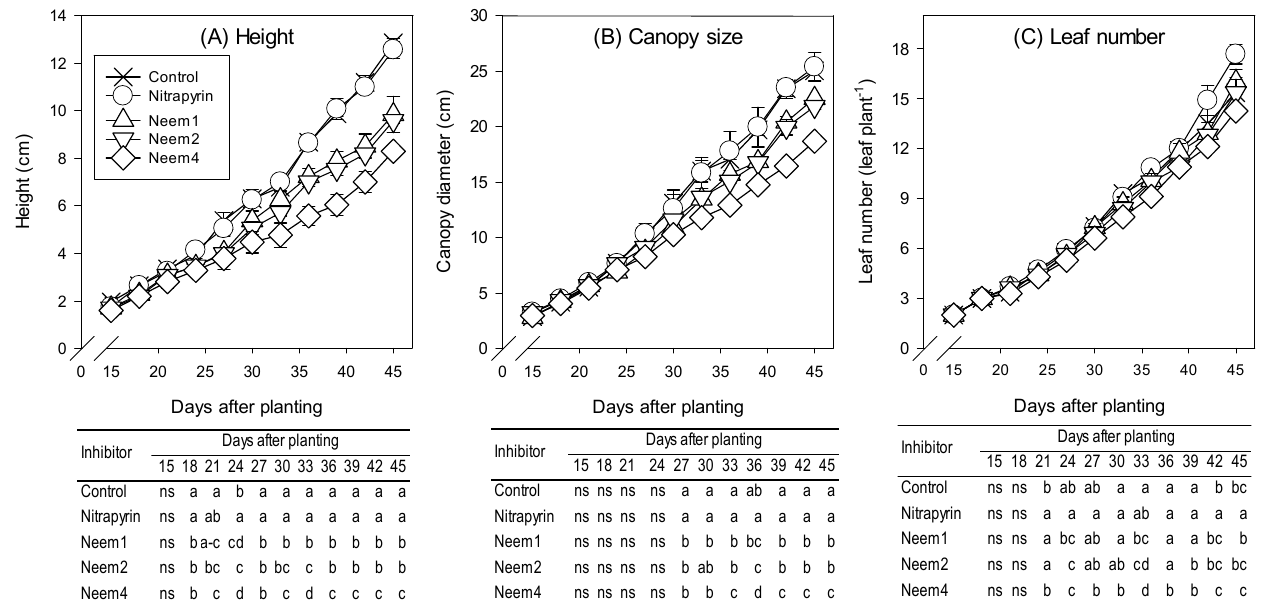
*** = p ≤ 0.001; CV = coefficient of variation. † Neem1, Neem2, and Neem4 = neem leaf extract based on the dry weight of the raw material at rates of 1, 2, and 4 g kg − 1 soil. ‡ Means within the same column followed by the same letter are not significantly different at p ≤ 0.05 (Fisher’s least significant difference test).